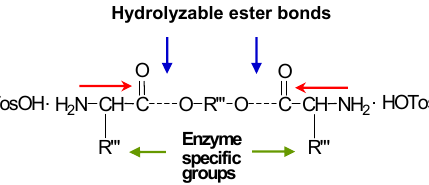
Figure 21. Structural peculiarities of AAAD-S monomers. Blue arrows, ester bonds; green arrows, enzyme specific groups; red arrows, the nonconventional “head-to-head”